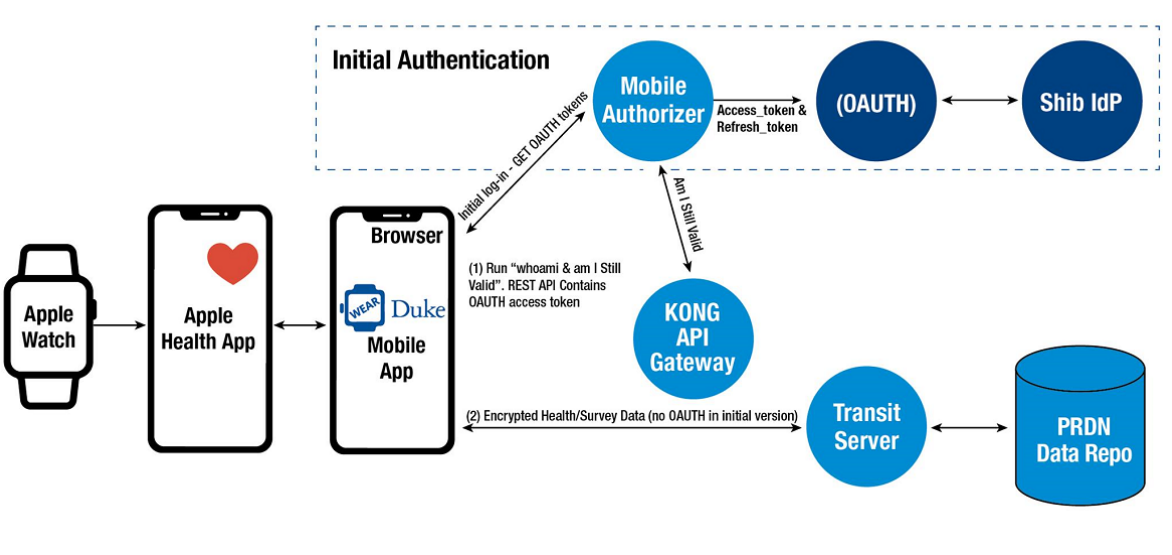
Figure 1. WearDuke iOS architecture. OAUTH: open authorization; Shib IdP: Shibboleth identity provider; KONG: Kong API Gateway; API: Application programming interface; REST API: Representational state transfer API; PRDN: Protected research data network; Repo: Repository; App: